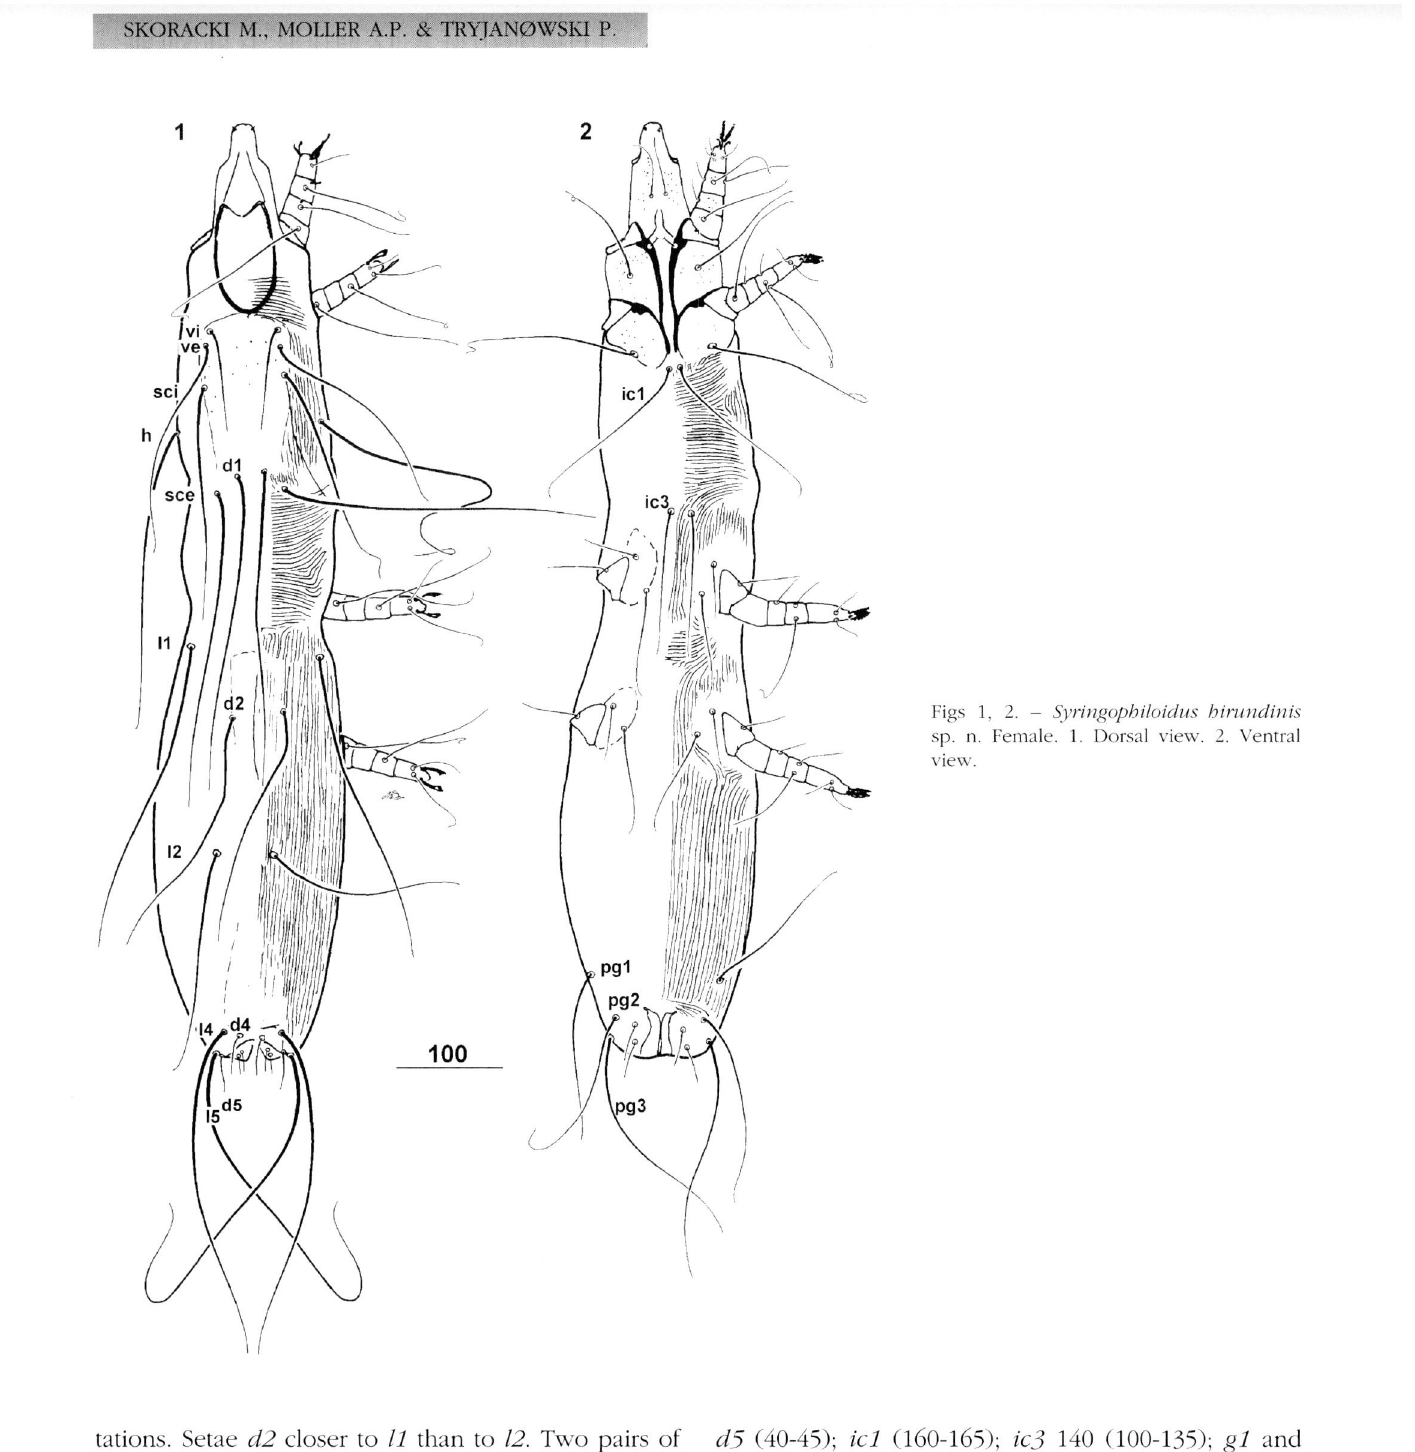
• Male (Figs 3, 4 and 7, 8) Total length 525-545 in three paratypes. stomal apex as in Figure 7. Stylophore 145-155 long, weakly constricted posteriorly. Peritremes M-shaped; each transverse branch with two-three chambers, each longitudinal branch with six-seven chambers (Fig. 8). Idiosoma. Cuticular striations as in Figures 3, 4. All dorsal plates (propodosomal, hysterosomal and pygi-